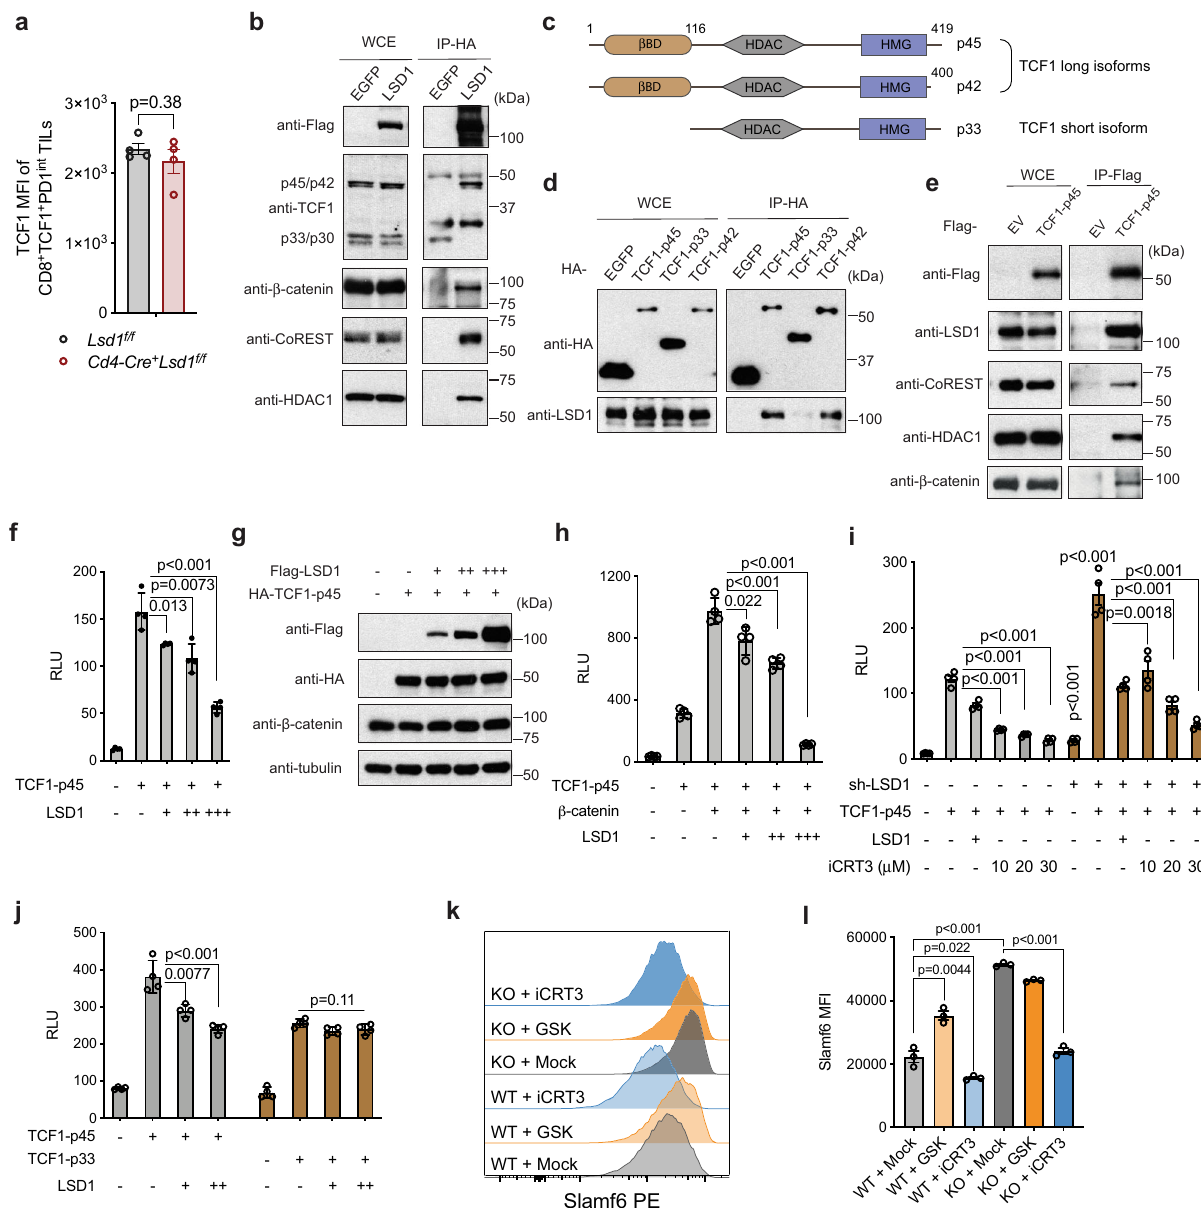
Fig. 5 LSD1/CoREST complex physically interacts with TCF1 and antagonizes its transcriptional activity. a MFI of TCF1 in CD8 + TCF1 + PD-1 int TILs analyzed by fl ow cytometry ( n = 4 per group). b The physical interaction between LSD1 and TCF1 isoforms as well as other proteins was examined by co- immunoprecipitation (co-IP) assays using whole-cell extract (WCE) of HEK293T cells transfected with FLAG-HA-tagged LSD1. c Schematic representation of different isoforms of mouse TCF1. d Co-IP assays precipitating HA-tagged TCF1 isoforms and detecting LSD1 in eluted IP fractions. e Co-IP assays precipitating Flag-tagged TCF1 (referring to p45 unless otherwise speci fi ed) and detecting components of the LSD1/CoREST complex in eluted IP fractions. f – j TCF/LEF reporter assay measuring relative luciferase units (RLU) in response to transfection with plasmids expressing indicated proteins ( f – j , n = 4 per condition) or shRNA targeting LSD1 ( i ) and the treatment with iCRT3 ( i ) ( n = 4 per condition). Protein expression for plasmid transfection in f is shown by immunoblotting ( g ). k , l Representative fl ow plots ( k ) and Slamf6 MFI ( l ) of splenic CD8 + T cells activated in vitro for 3 days with anti-CD3/anti-CD28 in the presence of vehicle, GSK2879552 or iCRT3 ( n = 3 per treatment). Data represent two ( a , b , d – j ) or three ( k , l ) independent experiments and are presented as mean ± SEM ( a ) or mean ± SD ( f , h – j , l ). Statistical signi fi cance was determined by two-sided unpaired t test ( a , f , h – j , l ). Source data are provided as a Source data fi